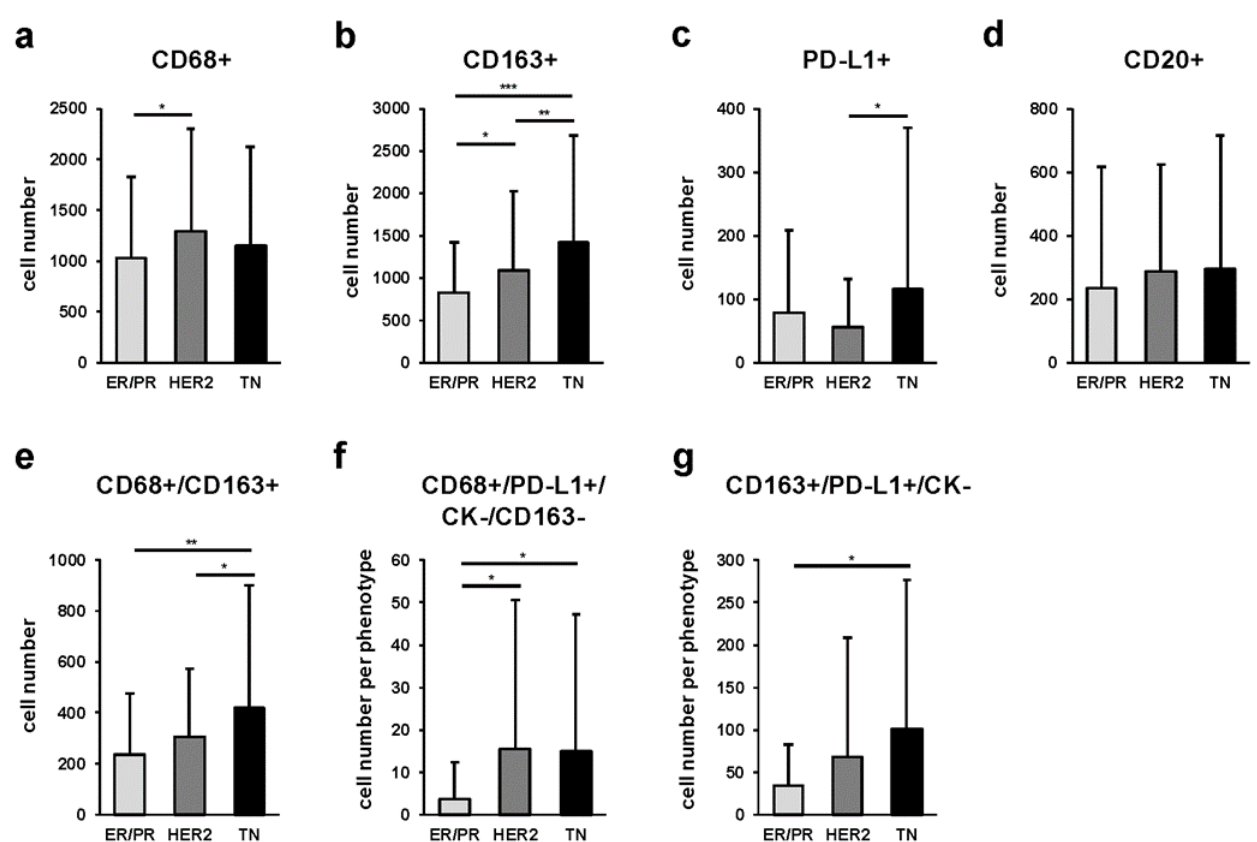
Figure 3. Comparison of single- and multiple-stained stromal TAMs (sTAMs), immune modifica- tion, and B-cell-marker-positive cells among ER/PR, HER2, and TN subtypes. Average number of single-marker-positive cells: ( a ) CD68+ (* indicates p = 0.047), ( b ) CD163+ (*, ** and, *** indicate p = 0.047, p = 0.030, and p < 0.001, respectively), ( c ) PD-L1+ (* indicates p = 0.029), and ( d ) CD20+ cells. Average number of multiple-marker-positive cells: ( e ) CD68/CD163 double-positive (* and ** indicate p = 0.048 and p < 0.001, respectively), ( f ) CD68+/PD-L1+/CK-/CD163- (* indicates p < 0.001), and ( g ) CD163+/PD-L1+/CK- (* indicates p < 0.001) per 1 mm 2 at 5 locations in each subtype; p -value was calculated using one-way ANOVA test and Tukey’s multiple comparison test. Error bars represent standard deviation.